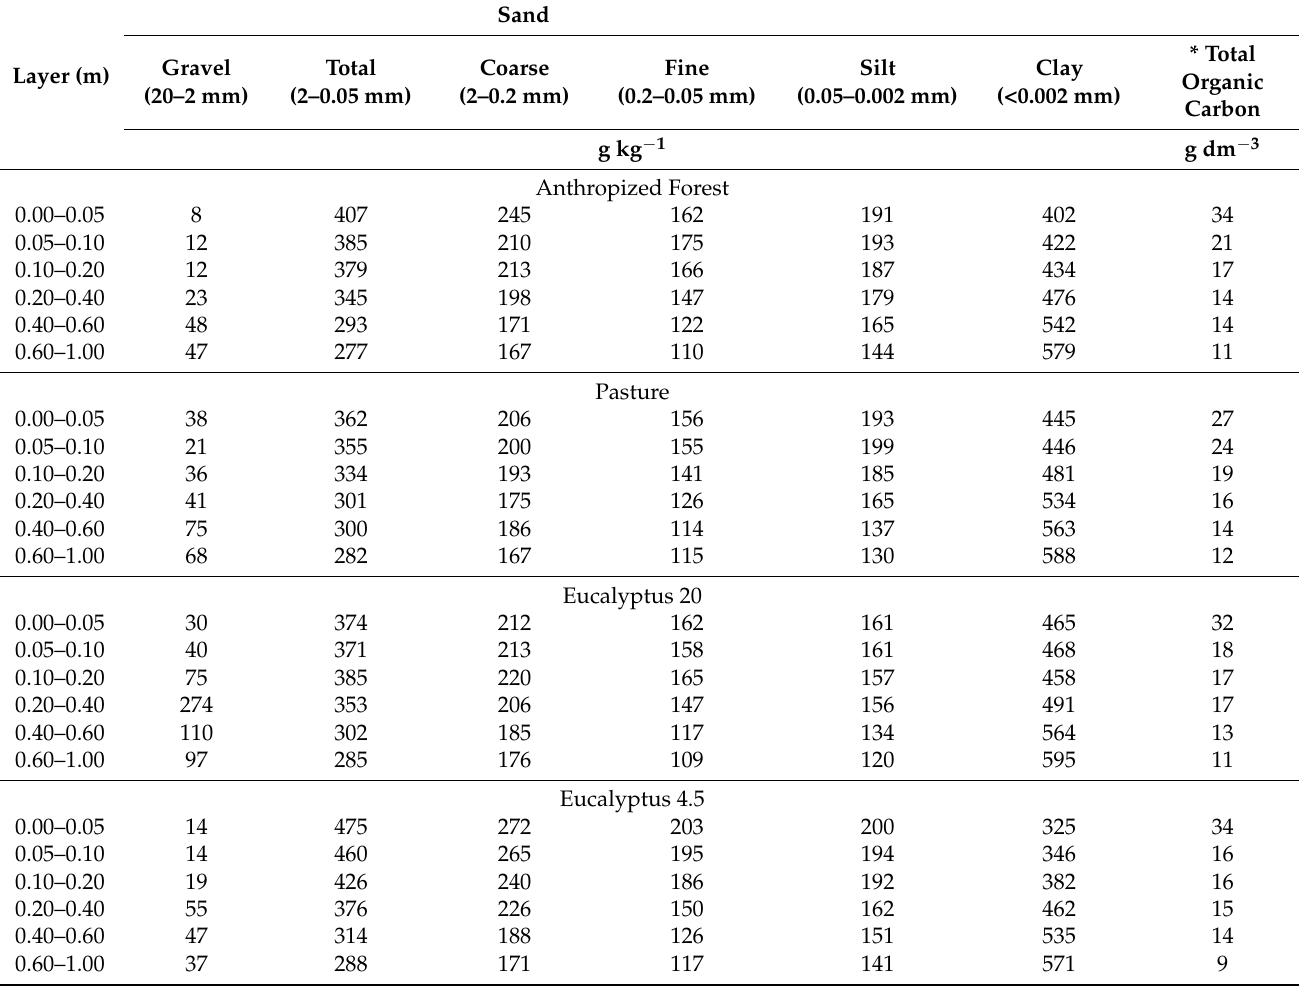
Table 1. Mean values of gravel, particle size distribution and total organic carbon for the studied land uses and six soil